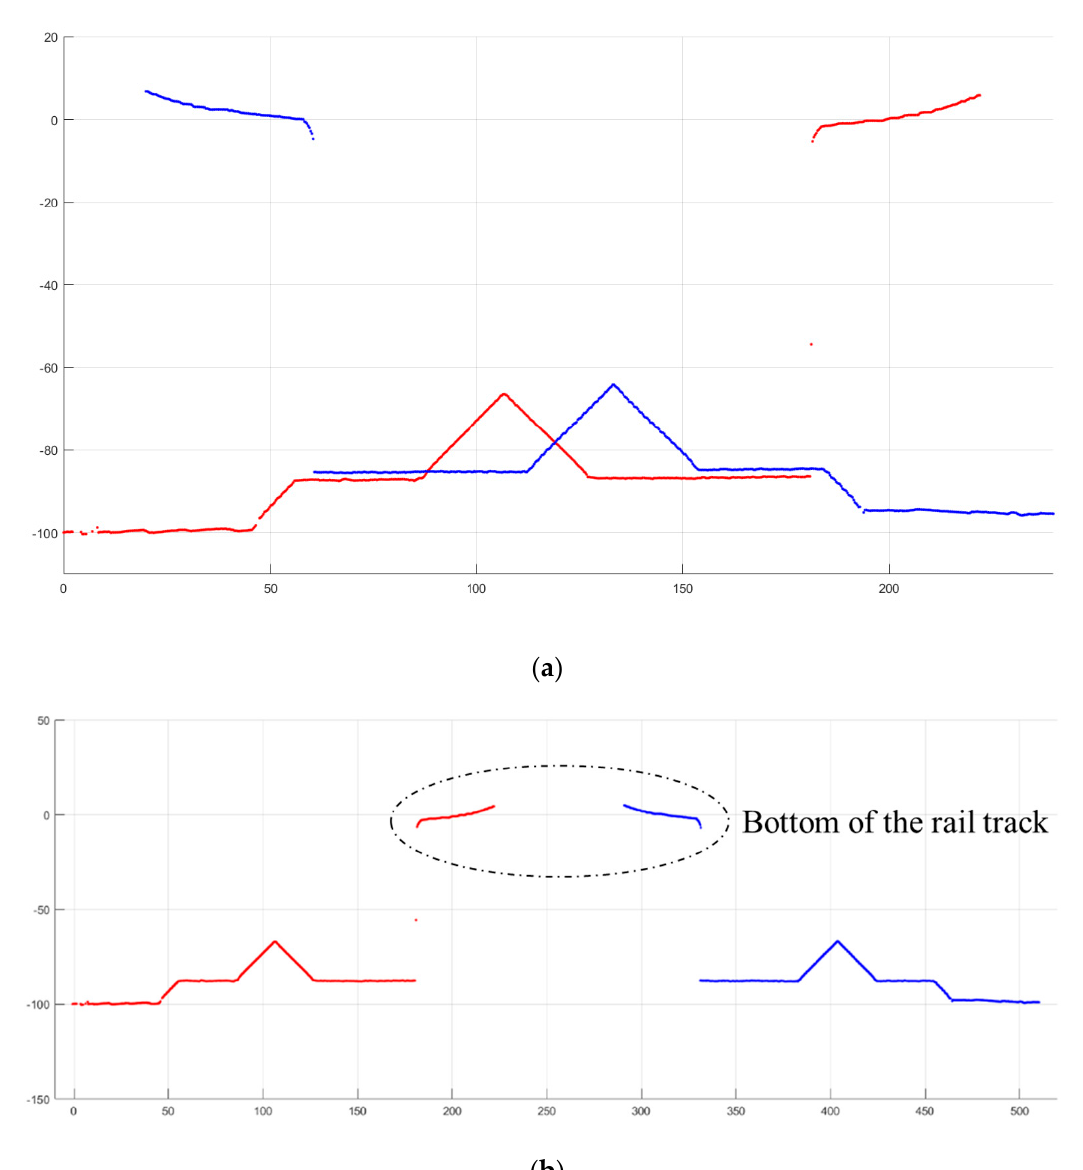
Figure 14. Calibration of the structured light sensors: ( a ) Original output of two consecutive sensors; ( b ) Side view of frames after calibration.